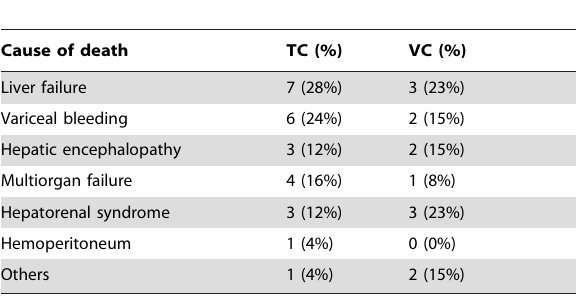
Table 2. Causes of death within one year in the training cohort (n=25) and validation cohort (n=13).